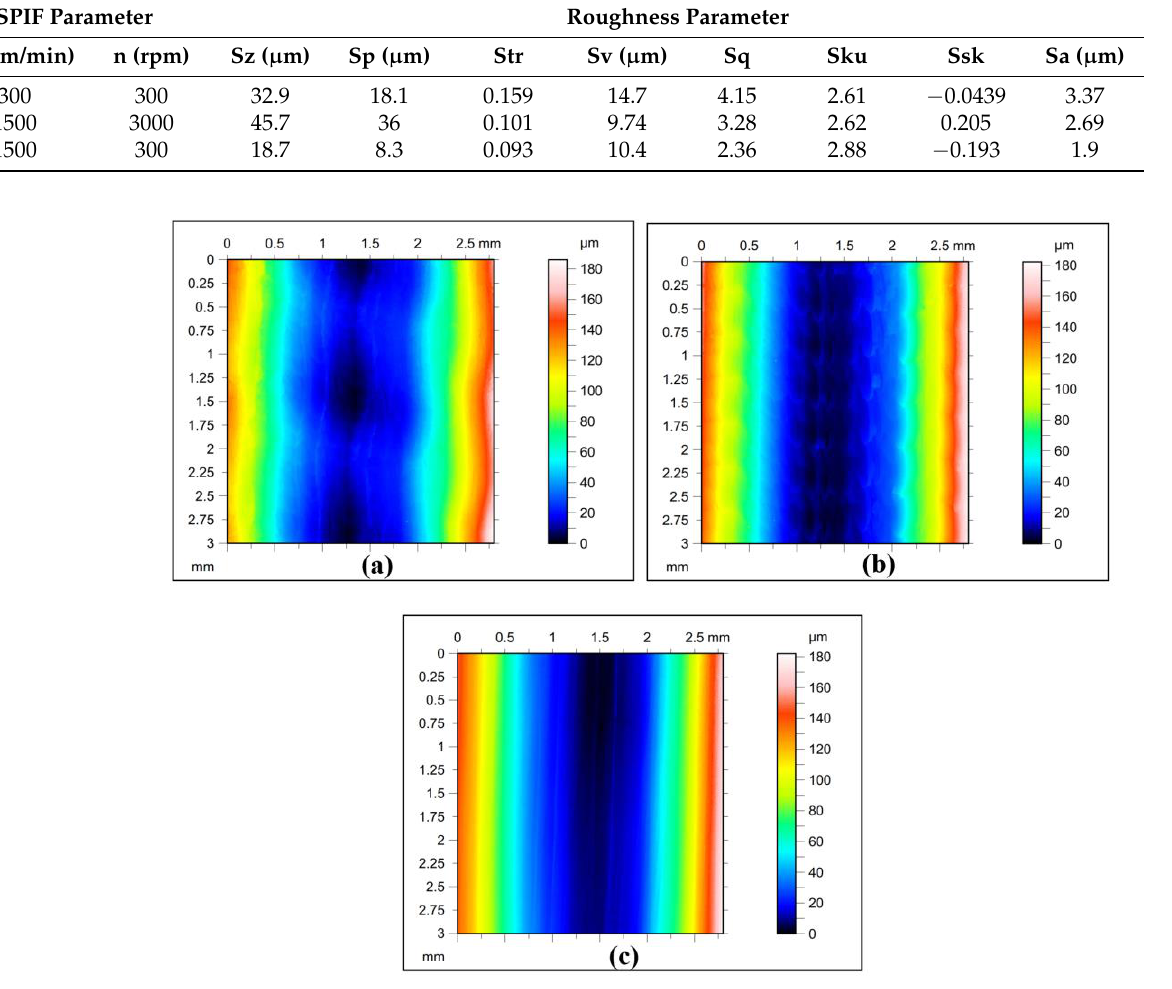
Figure 3. 2D profiles of measured sheets at ( a ) case A: f = 300 mm/min, N = 300 rpm ( b ) Case B: f = 1500 mm/min, N = 3000 rpm and ( c ) Case C: f = 1500 mm/min, N = 300 rpm.